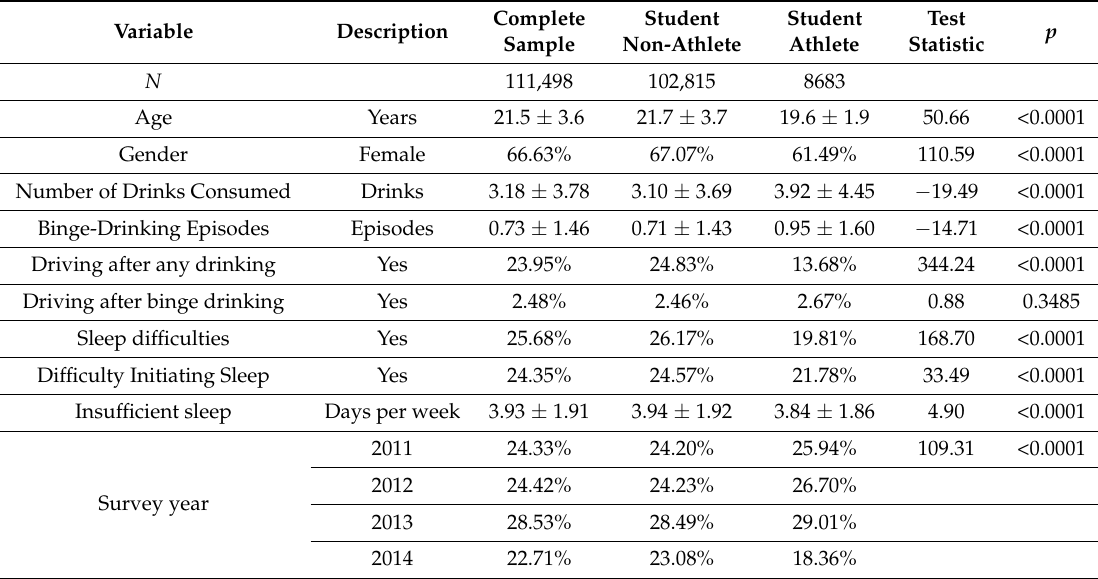
Table 1. Characteristics of the Sample.